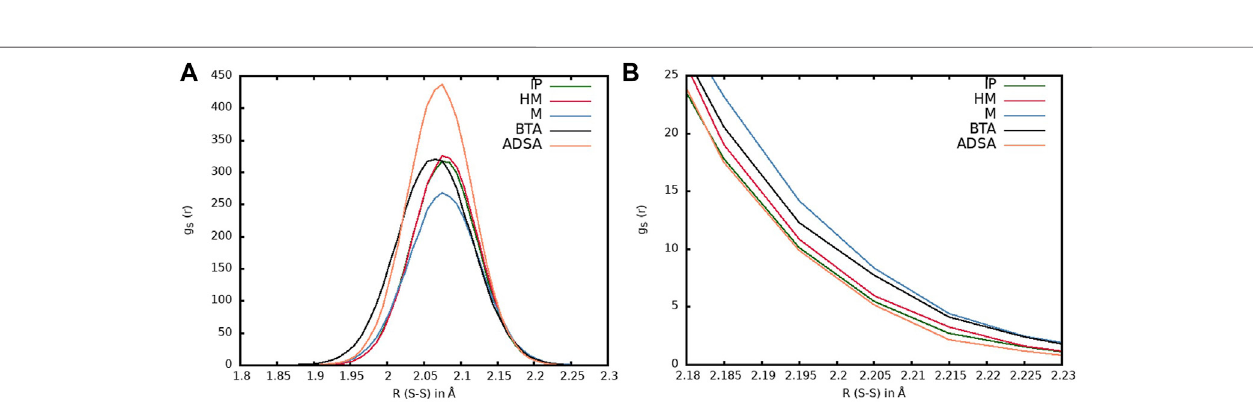
FIGURE 8 | (A) Radial distribution functions corresponding to the sulfur atoms within the same disul fi de bond for the fi ve models: IP (green line), HM (red line), M (blue line), BTA (black line) and ADSA (orange line). (B) Enlargement of the region between 2.18 and 2.23 Å.